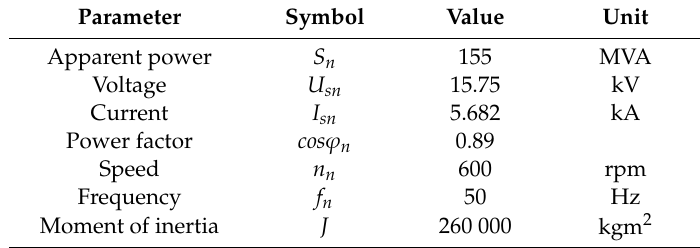
Table A1. Synchronous generator nominal data.